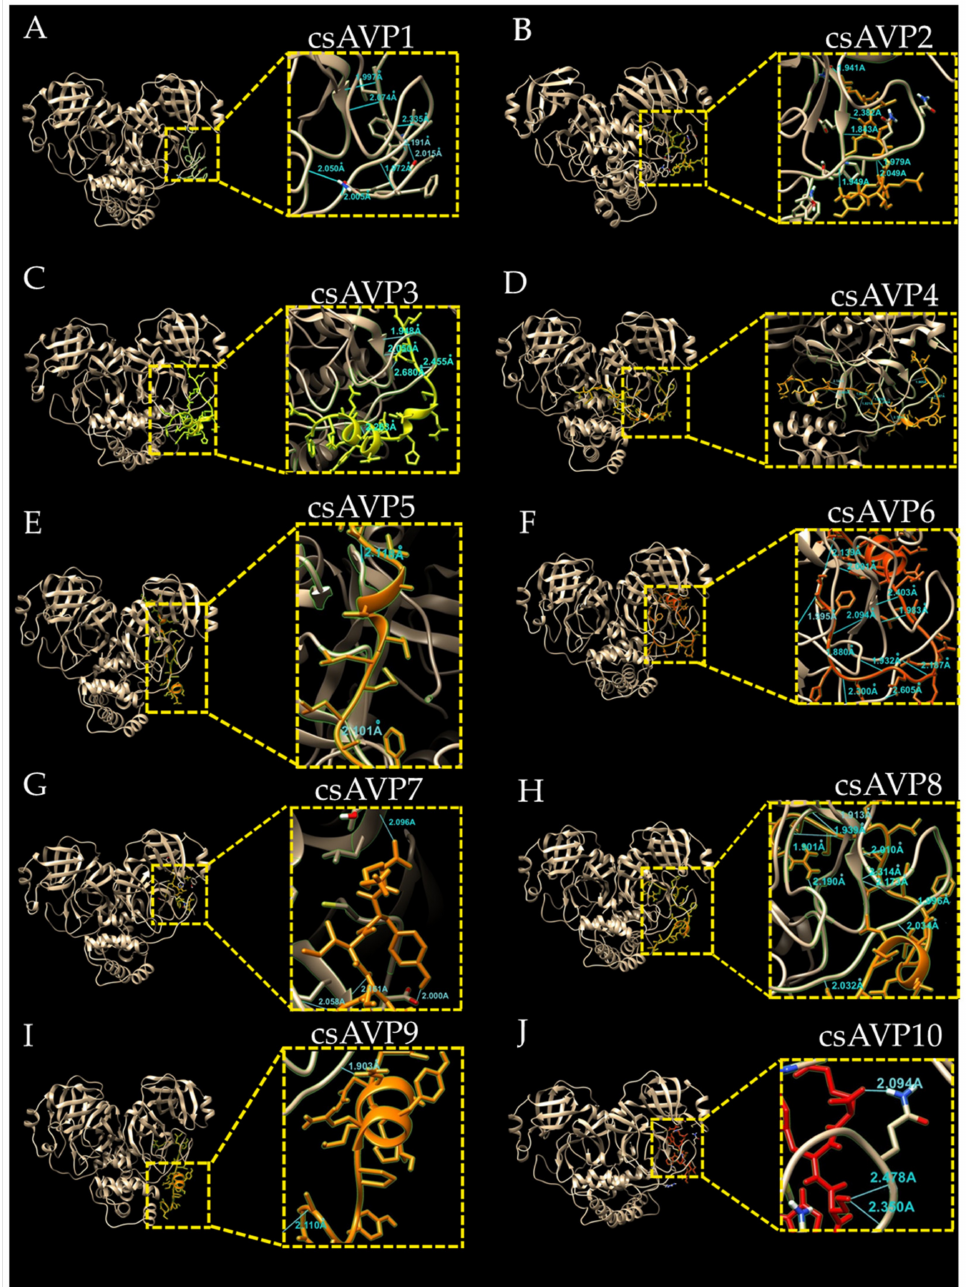
Figure 5. Molecular docking of the ten selected csAVPs (csAVP1-10) to the crystal structure of Coronavirus 3CL protease in the apo state (PDB ID: 7C2Q) ( A – J ). Structure of the coronavirus 3CL protease is shaded in gold, and the peptide chains are labeled with the csAVP number above. The blue lines indicate the hydrogen bonds with the value of bonding